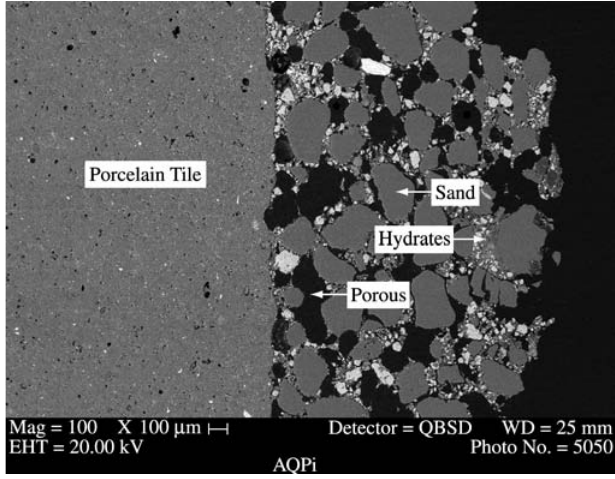
Figure 5. Backscattered electron micrograph of the polished surface. showing the interface between porcelain tile and mortar containing 5% silica fume and 20% latex.